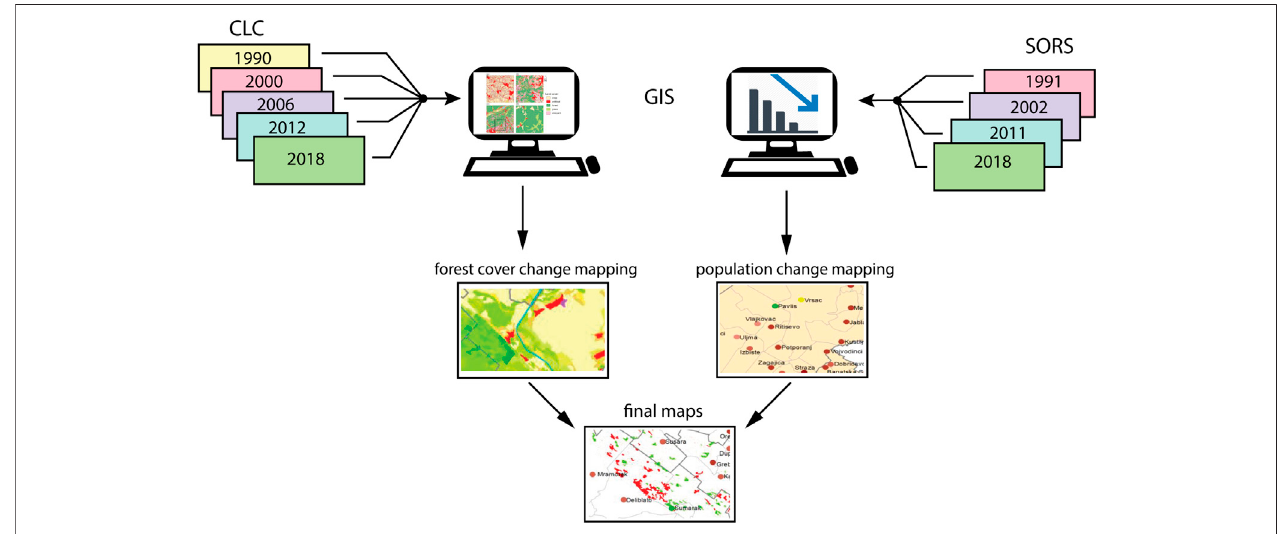
FIGURE 2 | Flowchart of the methodology applied in the